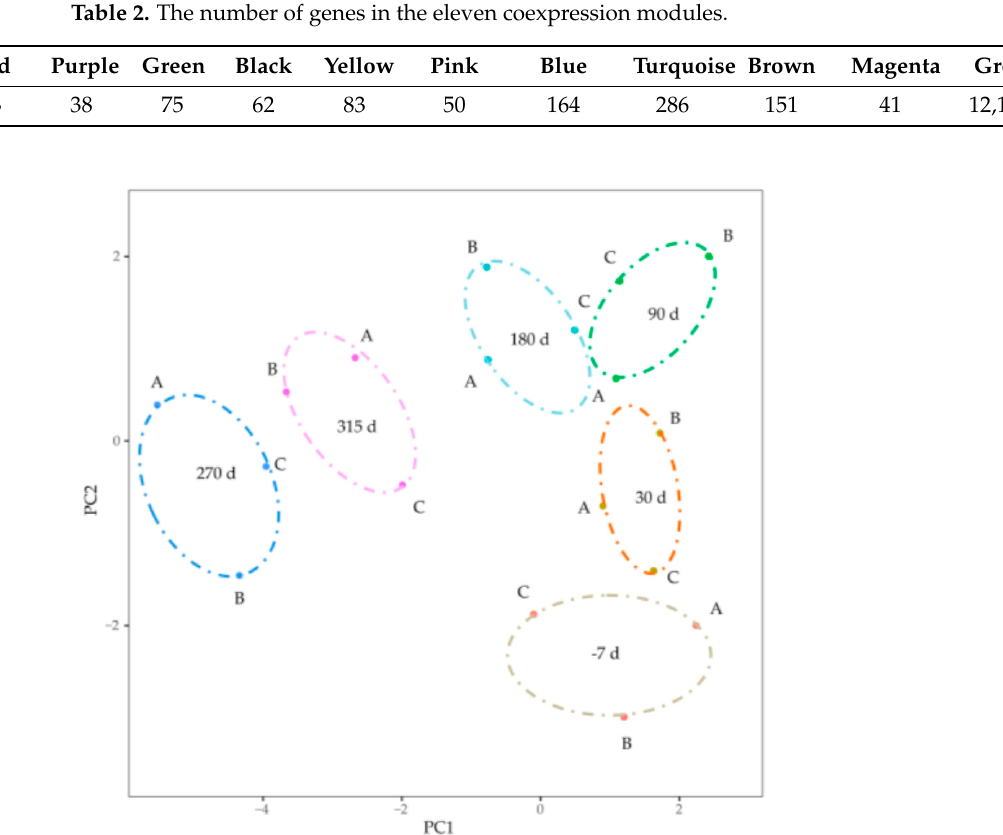
Figure 1. Visualizing the expression distribution of global genes by principal component analysis. The dots marked with A, B and C represented mRNAs form the three Holstein dairy cows. The ovals with different color represented different lactation stages.